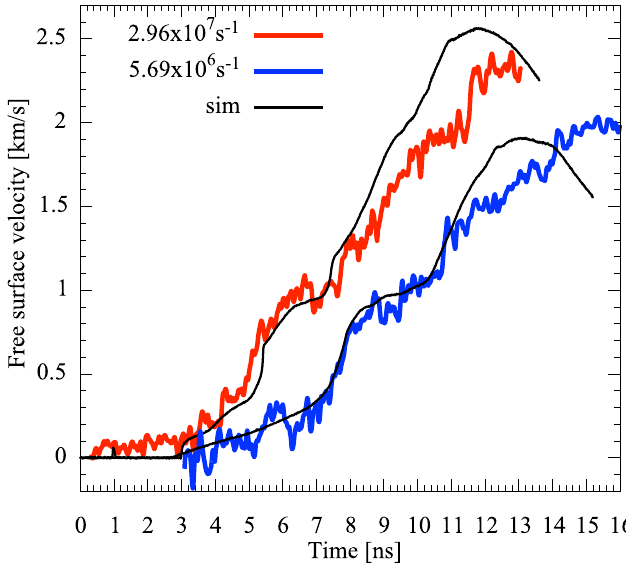
Figure 5. VISAR profiles for different loading rates for the iron 25 microns thick target. The thin black curves are the numerical simulation where the completion time θ was set to 3 ns. For clarity, the velocity profiles are temporally